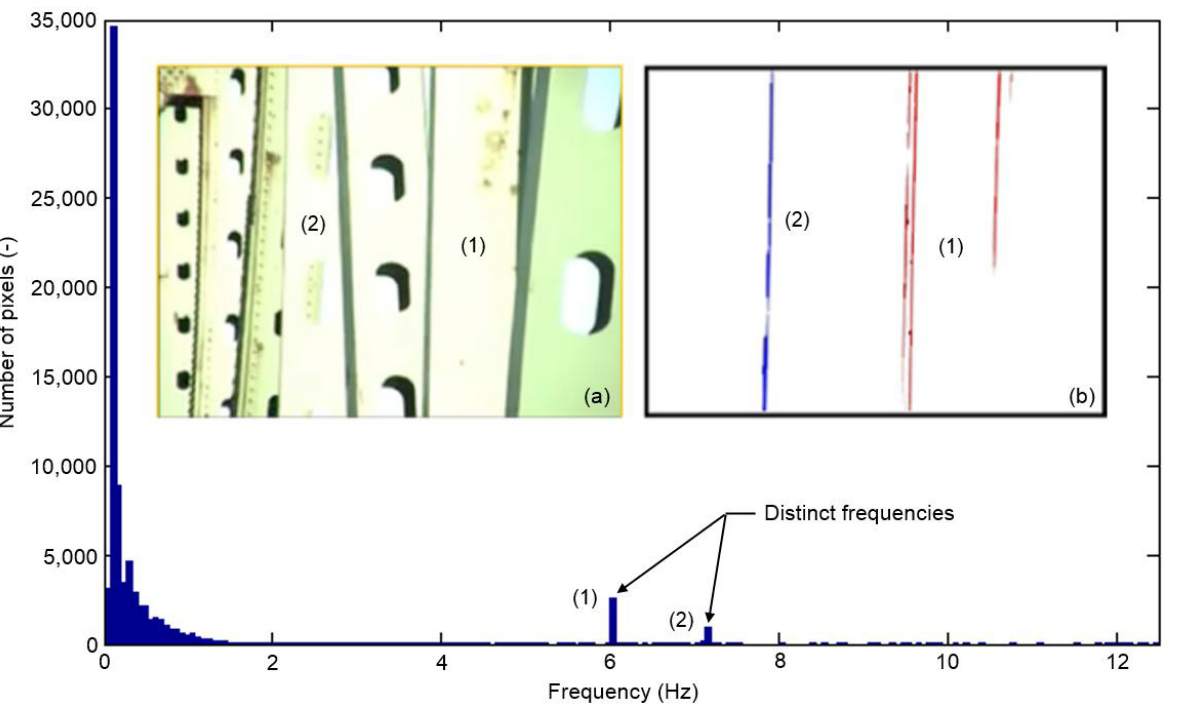
Figure 8. Histogram of peak frequencies from all pixels in the bridge video. Insert: ( a ) Snapshot of video clip; ( b ) Colored pixels with same